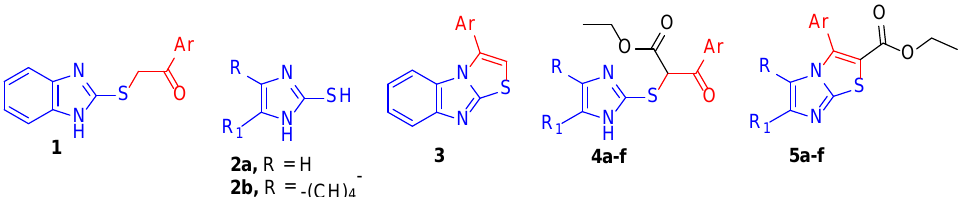
Figure 1. Chemical structure of compounds 1 − 5.